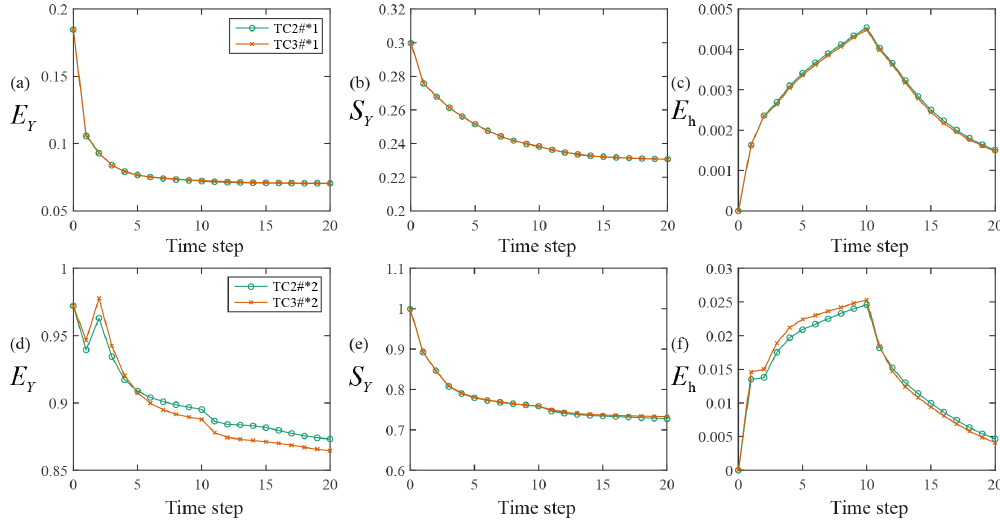
Figure 8. Temporal evolution of E Y (a, d) , S Y (b, e) , and E h (c, f) for TC2# ∗ 1 and TC3# ∗ 1 (a–c) and for TC2# ∗ 2 and TC3# ∗ 2 (d–f) .